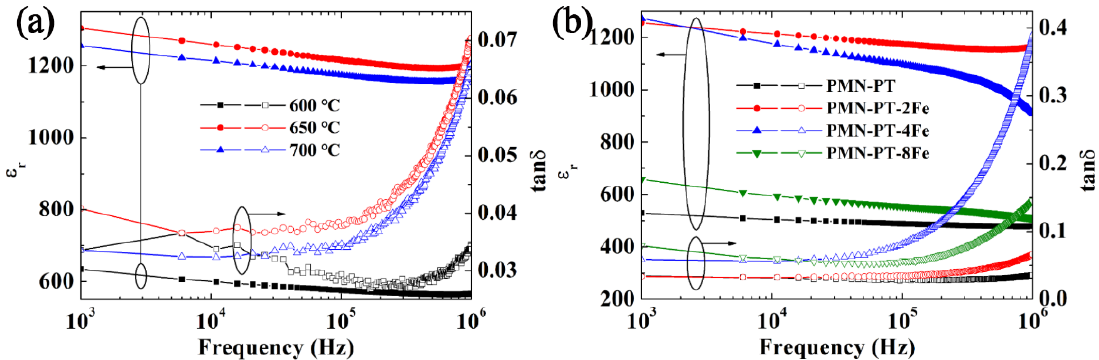
Figure 8. ( a ) The frequency dependence of ε r and tanδ of PMN -PT-2Fe thin films annealed at different temperatures, ( b ) The frequency dependence of the ε r and tanδ of PMN -PT-xFe thin films with different doping concentrations of Fe element.